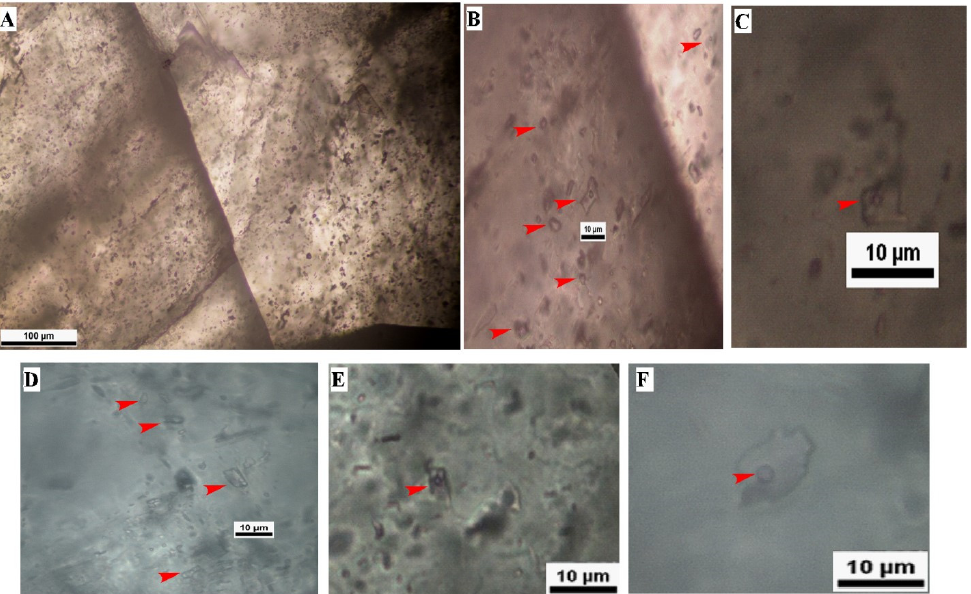
Figure 9. ( A ) Petrographic characteristics of biphasic fluid inclusions ( A – C ). The inclusions are present in the saddle dolomite and ( D – F ) fracture-filling calcite. The red arrow shows the position of the gas bubble.